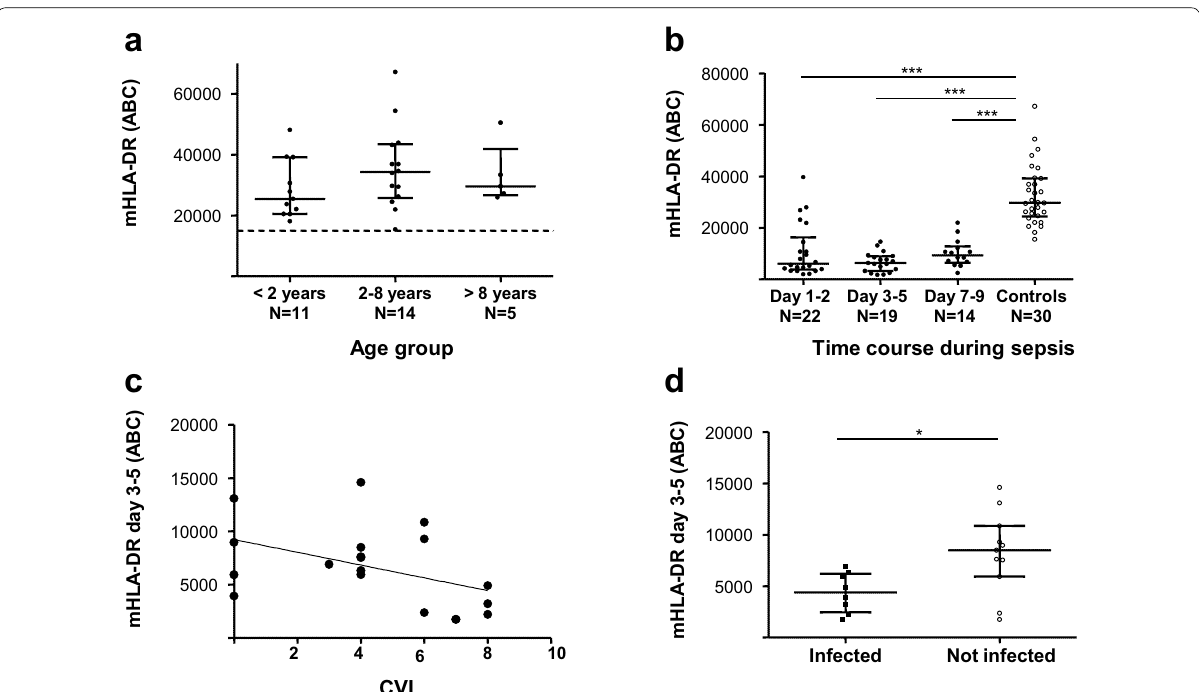
Fig. 2 mHLA‑DR measurements in pediatric septic shock. a mHLA‑DR expression in healthy children: no difference according to age groups ( p 0.35; ANOVA). Dashed line depicts usual threshold to define normal values in adults. b mHLA‑DR was significantly decreased at each time point = during septic shock, than controls ( p < 0.001; Mann–Whitney). c mHLA‑DR at day 3–5 was significantly negatively correlated with cumulative vaso‑ pressor index, CVI ( r 0.50; p 0.031; Spearman). d mHLA‑DR was significantly lower in children with secondary acquired infection than those = − = without ( p 0.022; Student t test) =